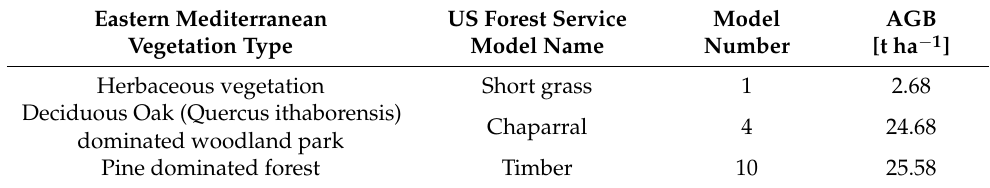
Table 1. Fuel models [28] for the base fuel map used for the simulations. Eastern Mediterranean